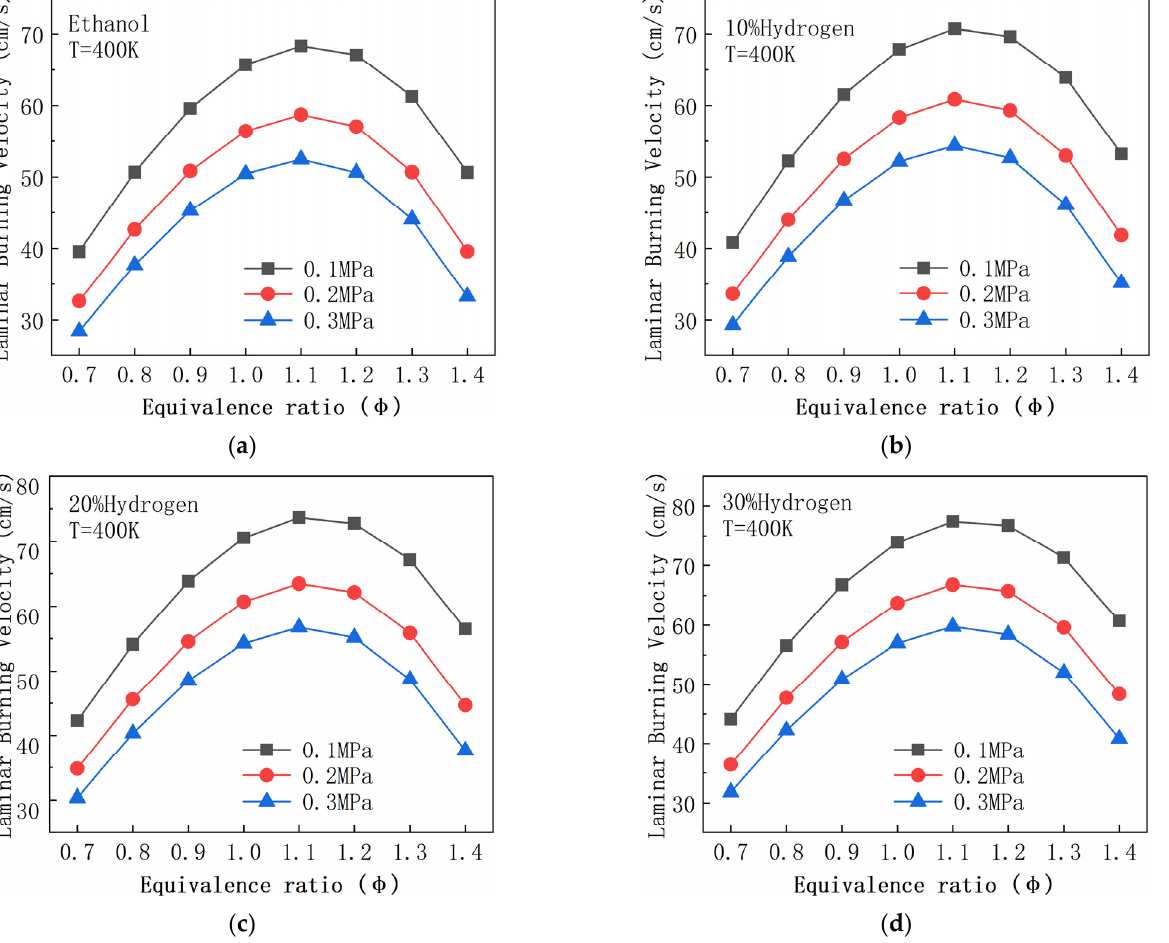
Figure 8. LBVs at different initial pressure and T0 = 400 K: ( a ) ethanol, ( b ) 10% hydrogen, ( c ) 20% hydrogen, and ( d ) 30% hydrogen.